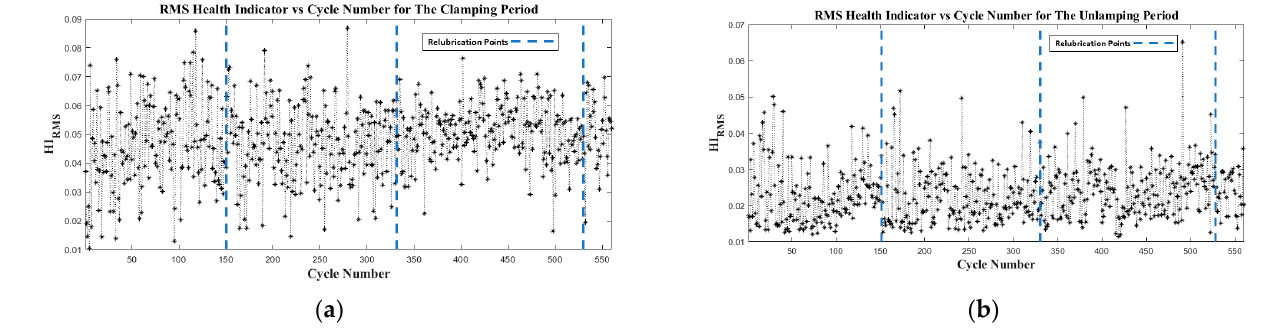
Figure 6. Time domain analysis for monitoring of the toggle’s lubricating condition: ( a ) Plot of RMS health indicator vs. cycle number for the clamping period; ( b ) plot of RMS health indicator vs. cycle number for the unclamping period.